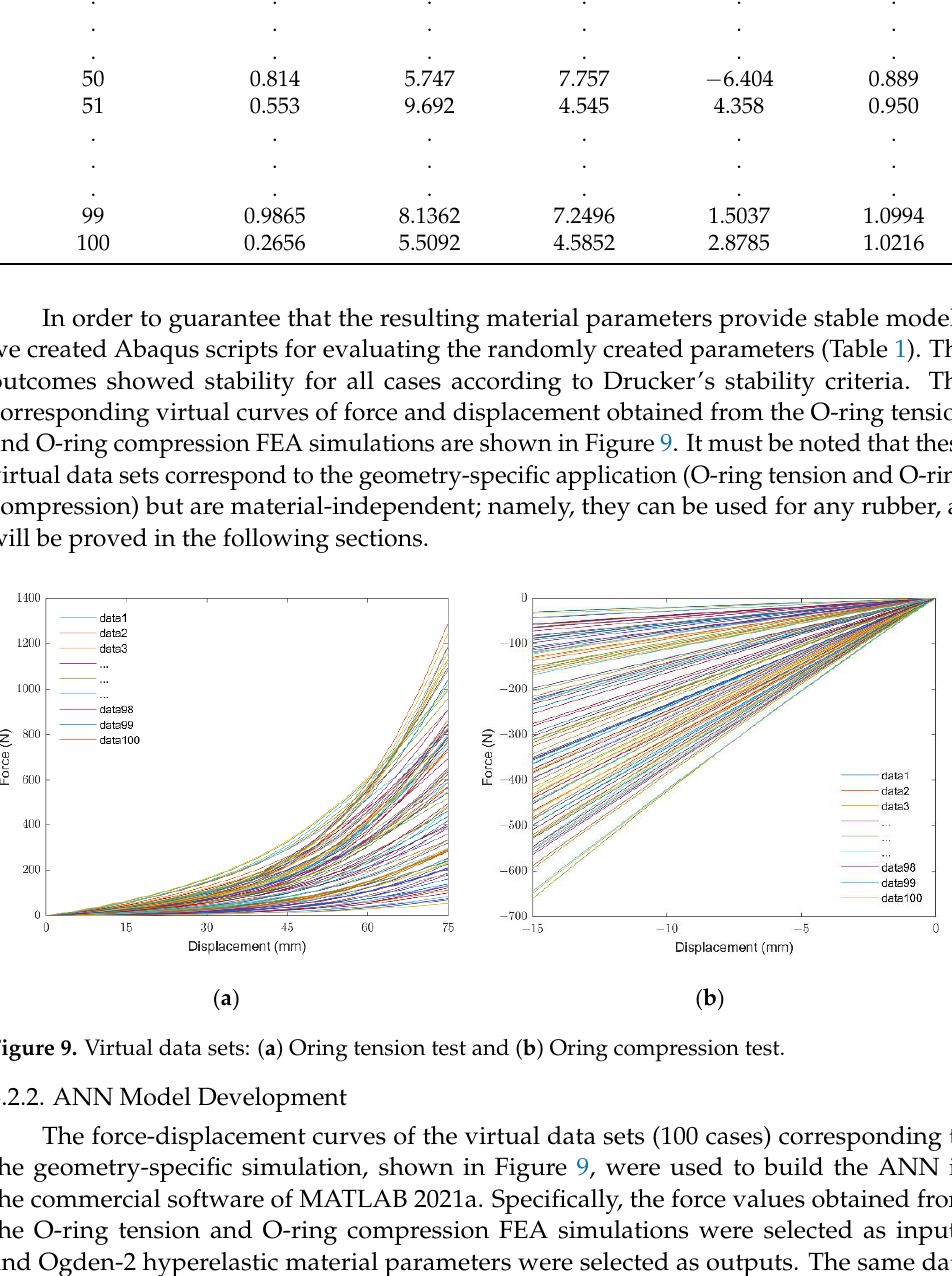
Figure 10. ANN structure with two hidden layers. Since it is not intended to determine the friction coefficient of rubbers in this study experimentally, it was added as an output parameter to the ANN model, assuming it is equal for both O-ring tension and O-ring compression tests. The developed ANN model contains fully connected layers: one input layer, two hidden layers, and one output layer. Levenberg – Marquardt ’ s backpropagation algorithm was selected as the training function, and the hyperbolic tangent sigmoid transfer function, tansig, was selected as the activa- tion function. The properties of the ANN model are provided in Table 2.